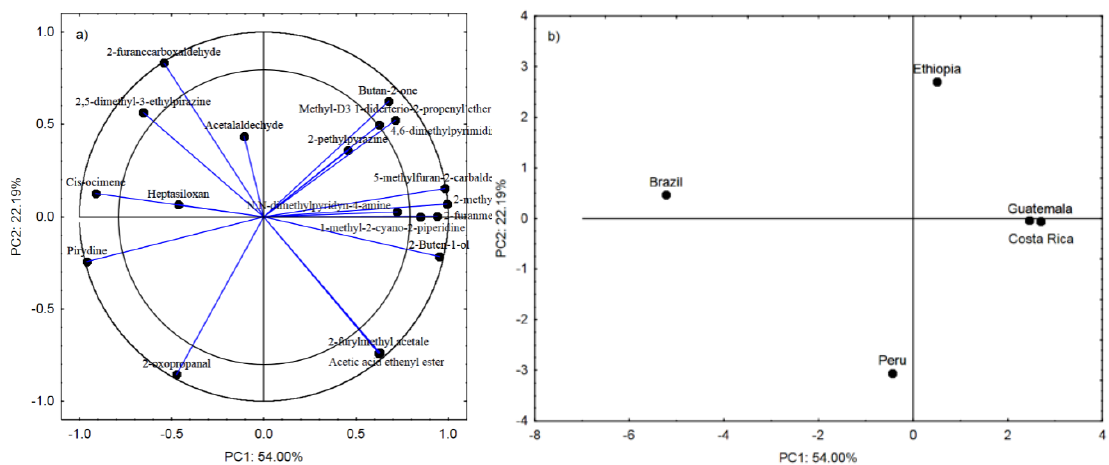
Figure 3. Loading plot ( a ) and score plot ( b ) of the principal components analysis carried out on the analytical data of the of the nineteen chemical compounds detected in all co ff ees from Brazil, Ethiopia, Guatemala, Costa Rica, and Peru.